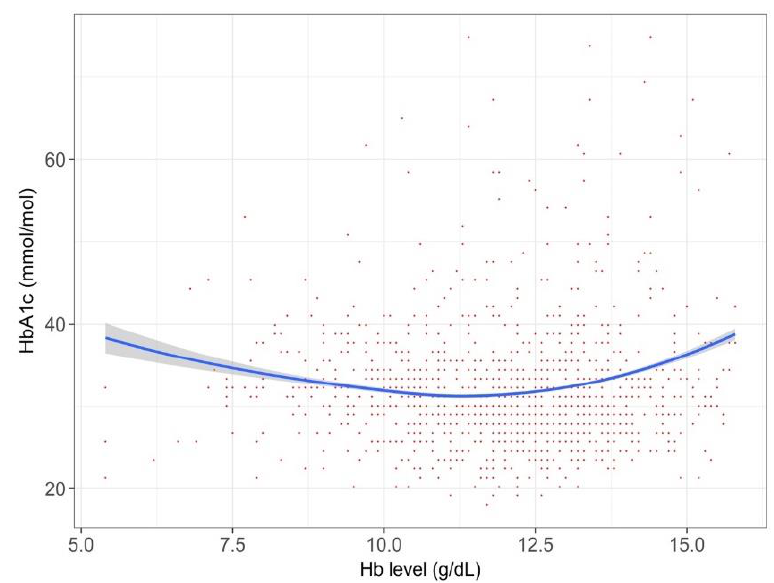
Figure 5. The relationship between Hb and HbA 1c values in persons with an iron prescription, within 90 days of their health checkup ( n = 956).